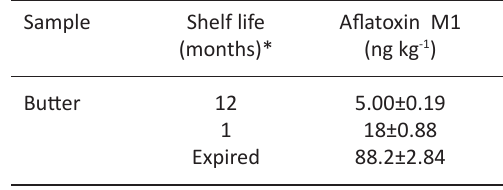
Table 3. Level of aflatoxin M1 in infant milk powder with different duration of expiry Sample Shelf